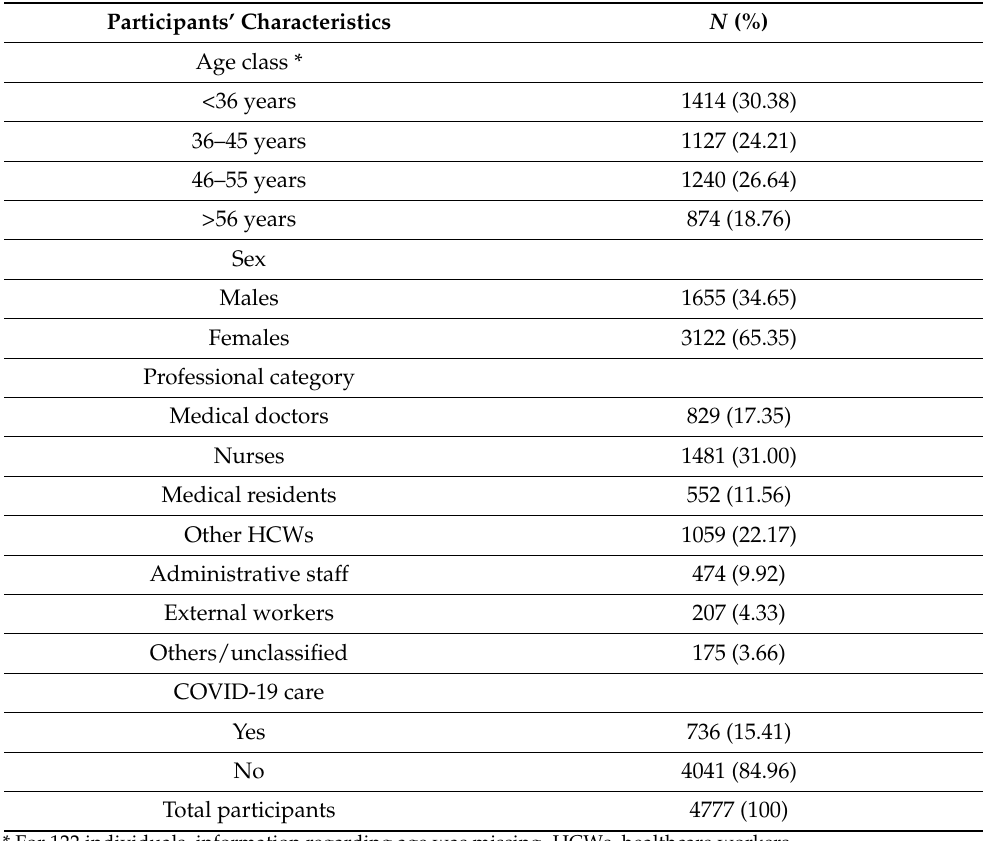
Table 1. General characteristics of enrolled